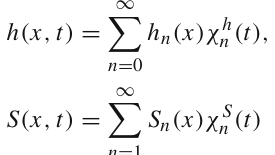
Fig. 1 Effective potential ˜ V (v S ) computed using the leading-order solution ϕ H , 0 ( t ) , for different values of t and M KK = 5TeV, k / m Pl = 1 / 8 and ¯ λλ S / r = 100, for β = 2 (blue) and β = 8